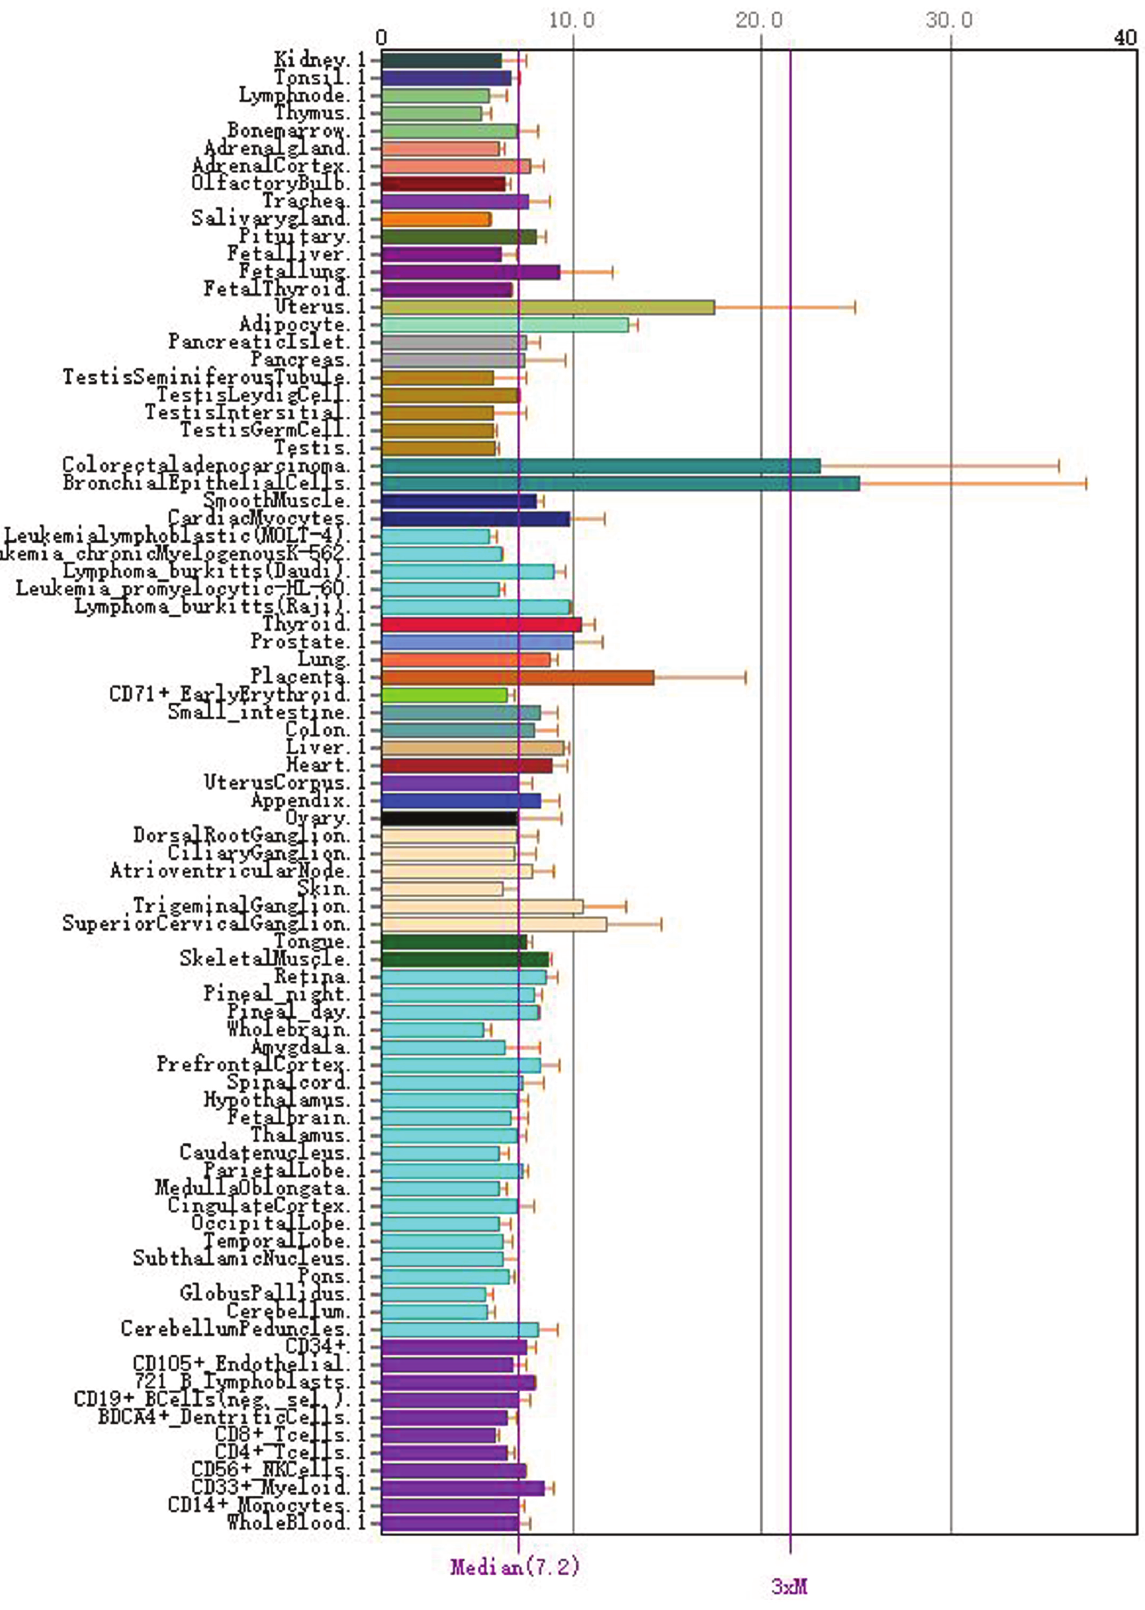
Figure 1: Expression of CD276 in normal human